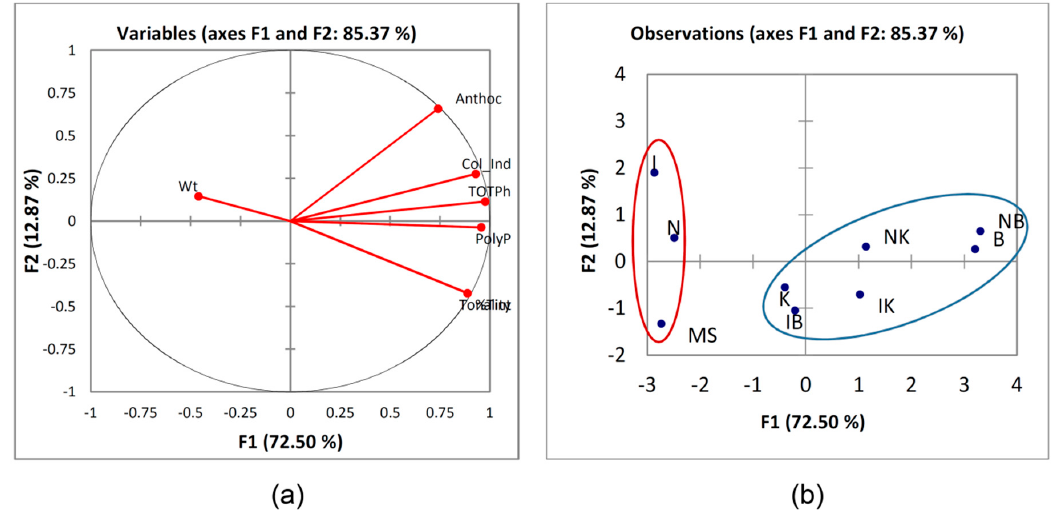
Figure3. ( a )Theloadingsplotand( b